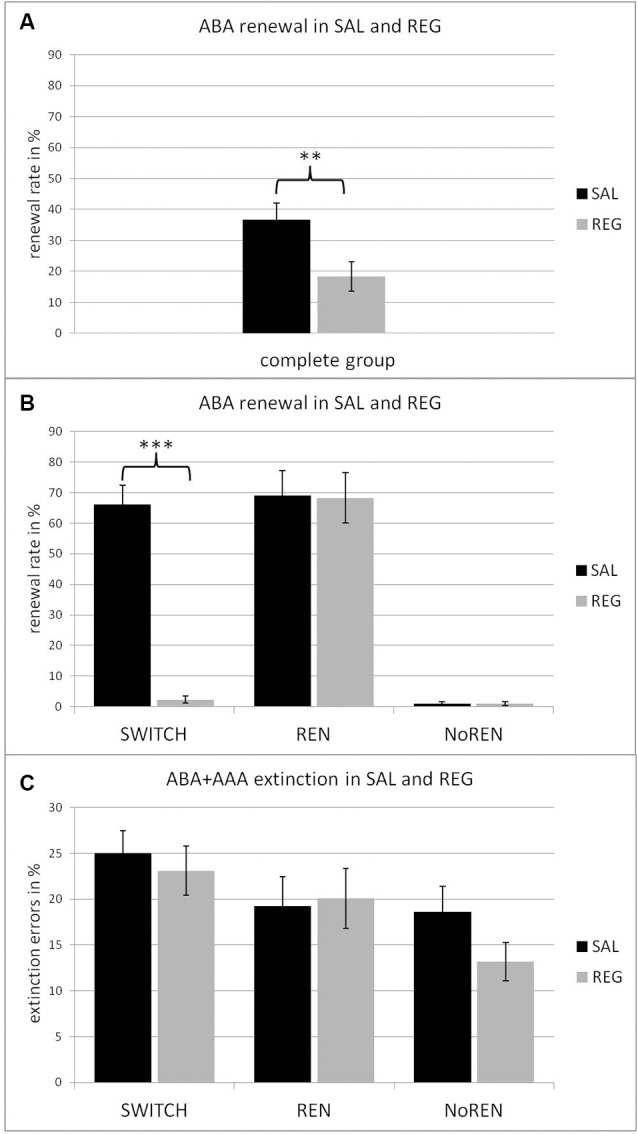
Renewal rates in the SAL (black) and REG (gray) conditions, in the complete group (A) and the three subgroups of SWITCH, REN and NoREN (B). The data show that the significant difference in the complete group (t(46) = 3.493, p = 0.001) is based on the change of renewal behavior in the SWITCH group, who exhibited significantly more renewal in the SAL than in the REG condition (t(12) = 10.041, p = 0.000). (C) Percent of extinction errors in the SAL (black) and the REG (gray) condition in the three subgroups. An ANOVA with repeated measures revealed a significant main effect of group, a Bonferroni post hoc test demonstrated a significant performance difference between the SWITCH and the NoREN groups. **p < 0.01, ***p < 0.001.